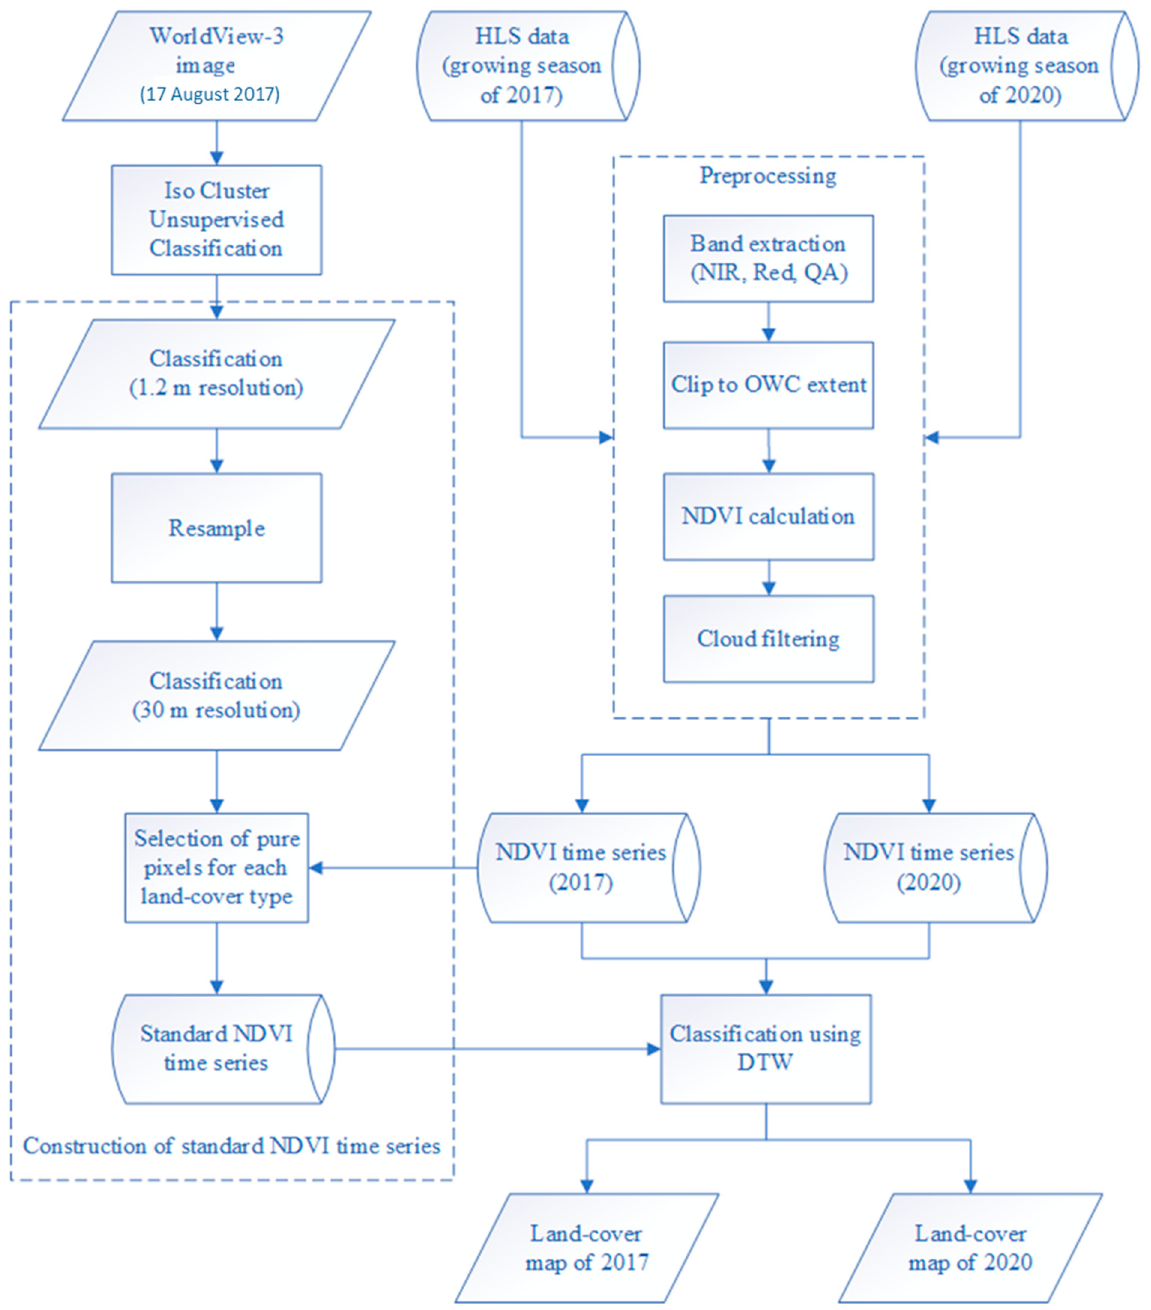
Figure 2. A schematic flowchart of the classification process using the NDVI time series computed from the HLS dataset. Cylinders represent datasets; rhombuses mark model outputs; and rectangles represent data analysis processes. Arrows represent the flow of data, and dashed frames identify different sub-stages of the analysis